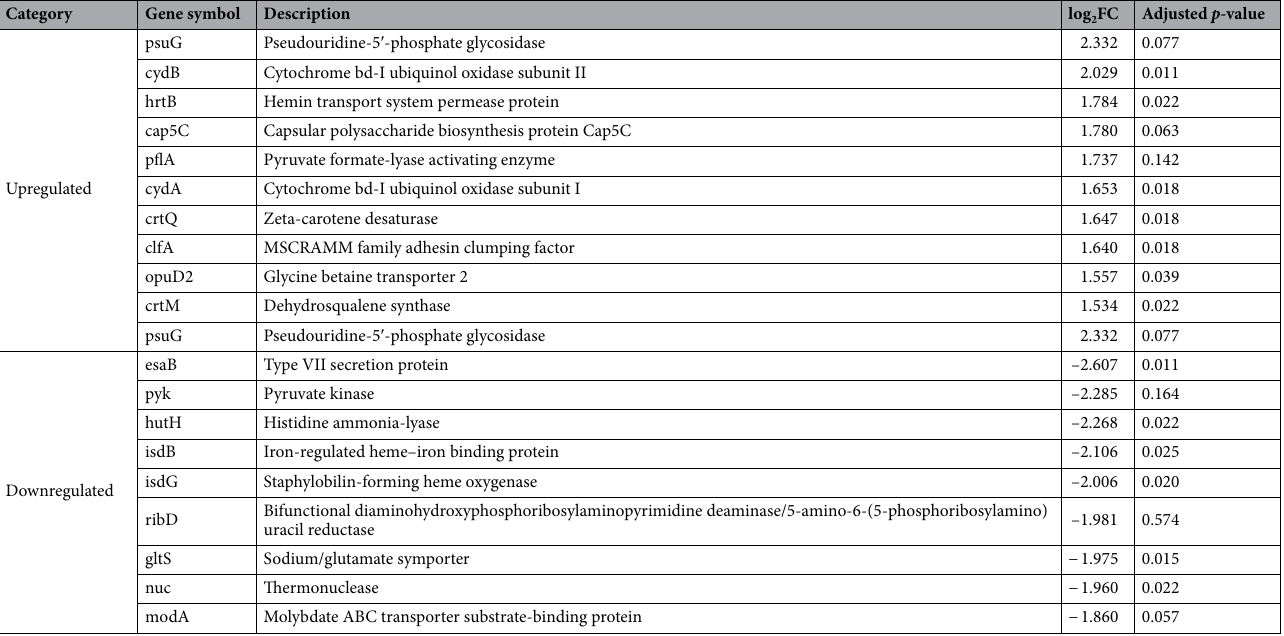
Table 2. Top10 up and downregulated genes in DEGs. FC fold